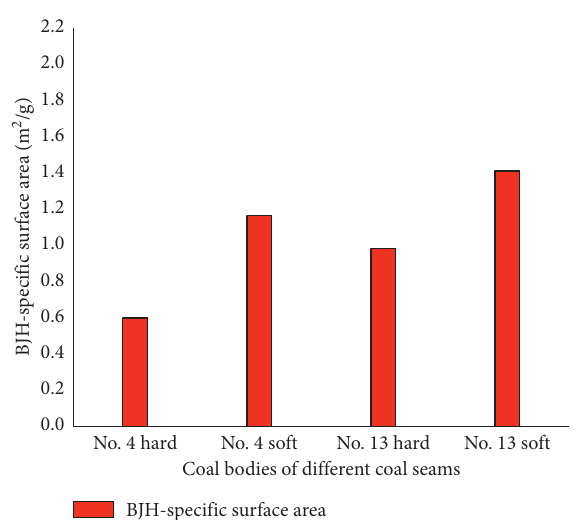
Figure 7: BJH-specific surface areas of the different coal